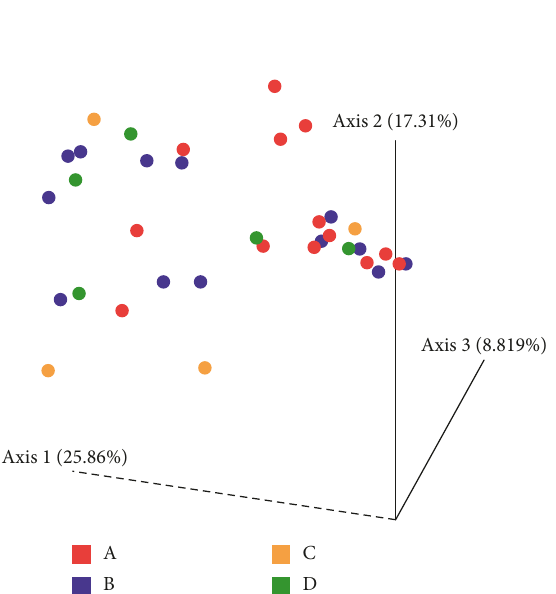
Figure 5: Principal coordinate plot of weighted UniFrac data. Colors keyed on the group: A (red), B (blue), C (orange), and D (green). Primary vector explains 25.8% of the variation between the groups. The first 3 vectors together exhibit 51.9% of the variation among the